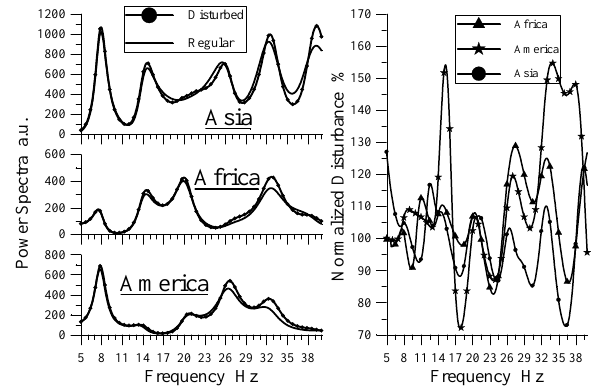
Fig. 5. Model Schumann resonance spectra and field disturbance when the regular and disturbed Earth-ionosphere cavities are ex- cited by a point lightning source in Asia (10 ◦ N, 105 ◦ E), Africa (0 ◦ N, 25 ◦ E), or America (10 ◦ N, 60 ◦